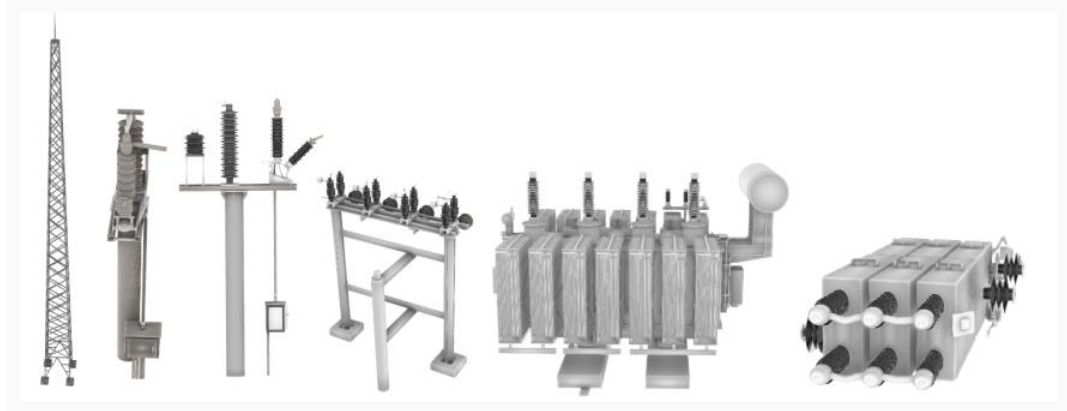
Figure 7. Part of a 3D CAD model in the substation building model base.